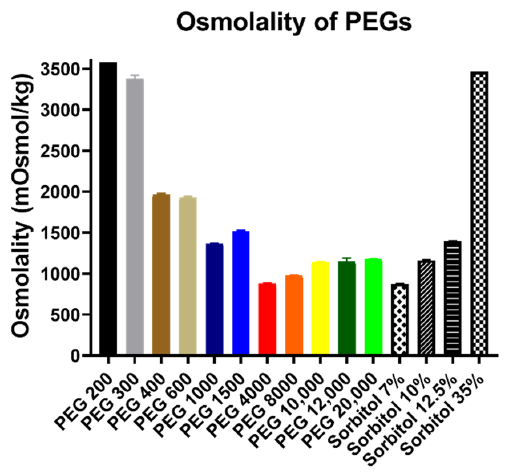
Figure 1. Osmolality of PEG and sorbitol solutions measured by vapor pressure osmometer OSMOMAT 070. Concentrations of all PEG solutions were 30 w / v % and volumes were 1 drop of the solutions each time. Columns represent the mean, ± SEM, n = 4. Osmolality of the samples in mOsmol/kg (mean ± SEM): PEG 200: 3574 ± 0; PEG 300: 3381 ± 38; PEG 400: 1963 ± 17; PEG 600: 1926 ± 17; PEG 1000: 1363 ± 4; PEG 1500: 1515 ± 11; PEG 4000: 877 ± 9; PEG 8000: 977 ± 3; PEG